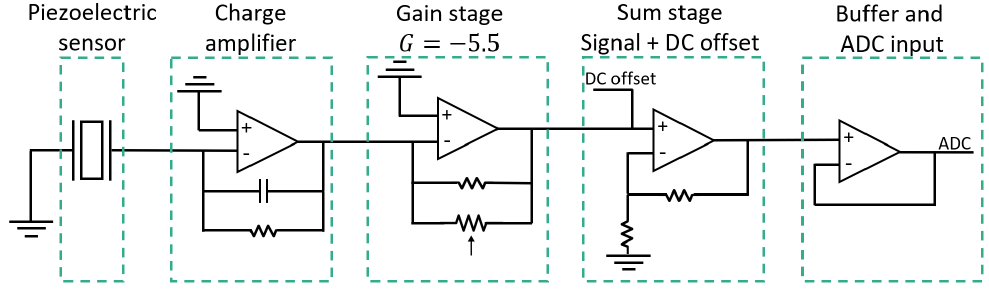
Figure 5. Schematic of the designed circuit for the piezoelectric sensor, with the signal modulation stages and optimized value for gain